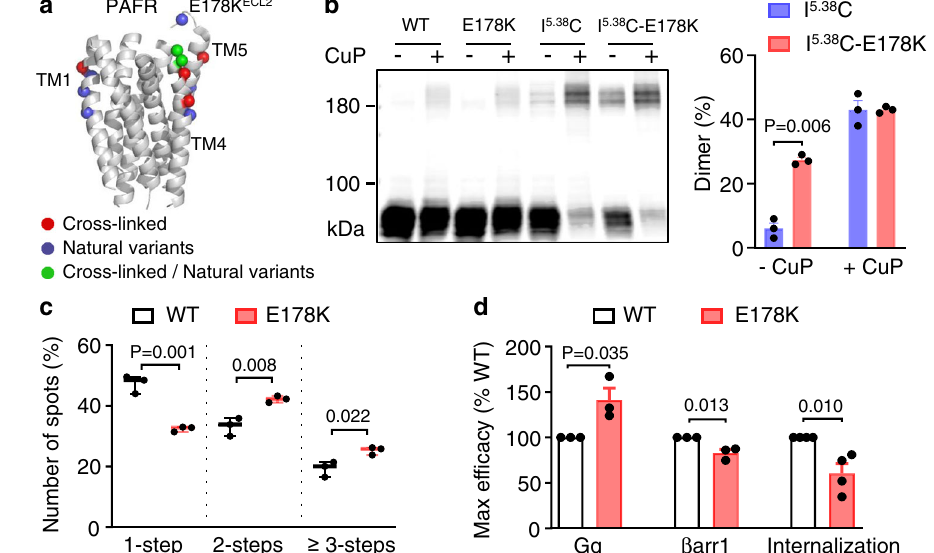
Fig. 5 | A natural genetic variant promotes PAFR dimerization and induces biasedsignaling.a 3Dstructureofthe7TMofPAFR(PDBcode:5ZKQ),lateralview. Amino acids ( α carbon) that can be cross-linked by a cysteine in TM1, 4, and 5 (red sphere), that corresponds to natural genetic variants (blue sphere), and that is in bothsituations(greensphere)arehighlighted. b Blotsshowingcross-linkingofcell surfaceHalo-PAFR subunits containing a cysteine substitution in TM5 (I186C 5.38 ) or containing the indicated variant together with I186C 5.38 , with or without treatment with CuP. Data are mean±SEM of n =3 biologically independent experiments and were analyzed using paired two-tailed t -test. The blot is representative of a typical experiment from n =3 biologically independent experiments. c Summary of